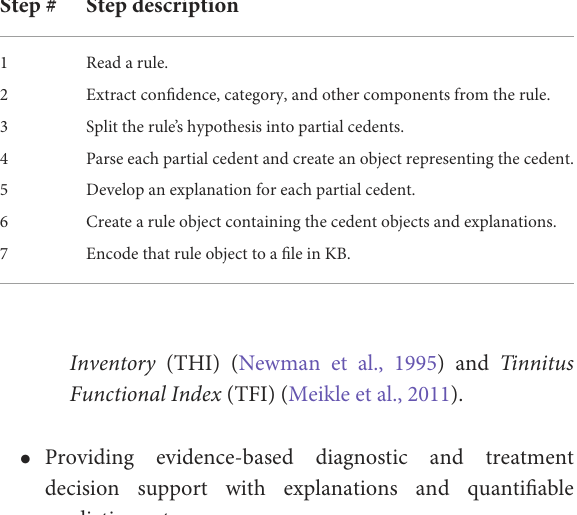
TABLE 1 Steps in the Knowledge Translator procedure. TABLE 2 Feature selection results for categorizing patients based on chi-squared ranking in